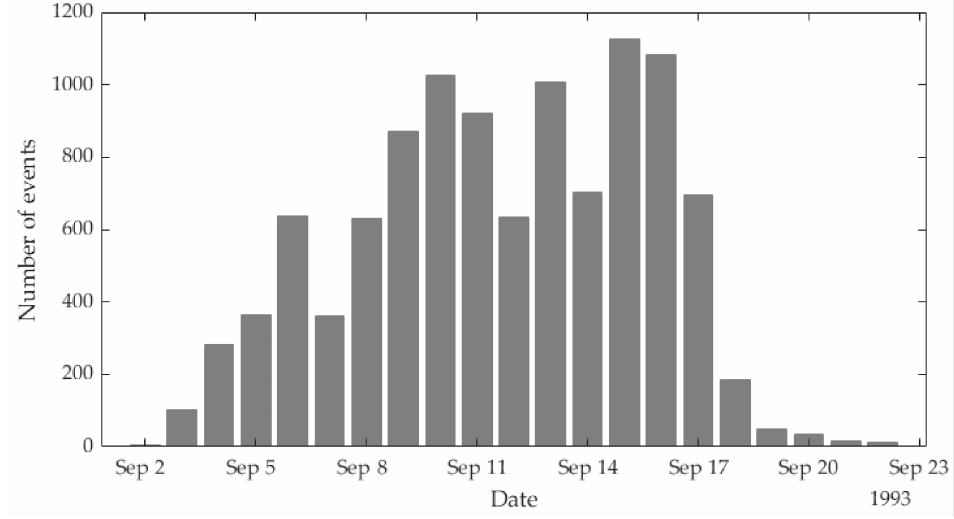
Figure 4. Daily number of microseismic events during the September 1993